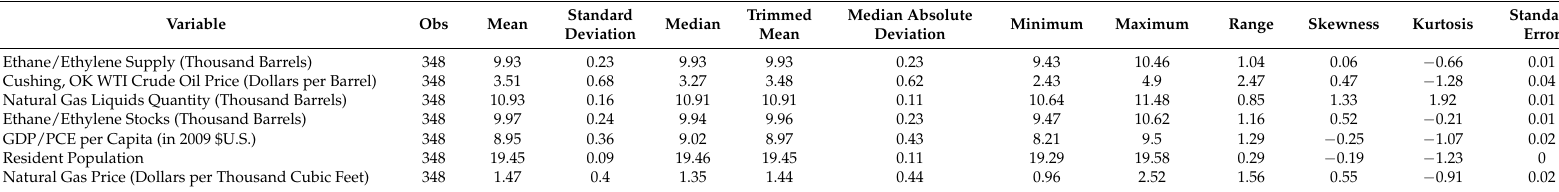
Table 1. Summary